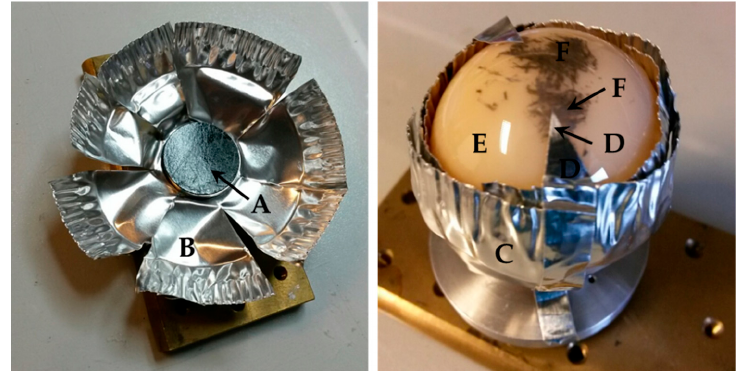
Figure 3. Double-sided carbon adhesive tape (A) in aluminum sample holder (B). Right: inserted ceramic femoral head in closed aluminum sample holder (C) with aluminum adhesive tape (D) on original head surface (E) and deposited area